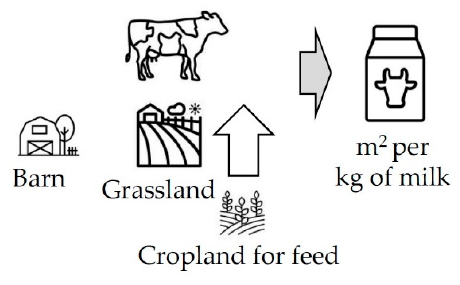
Figure 3. Milk production systems. Source of icons: the Noun Project [15].